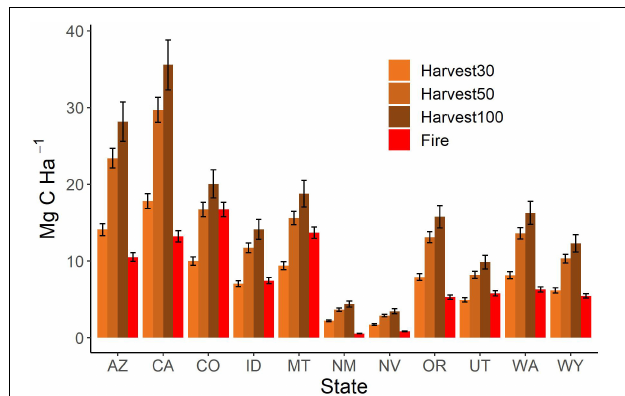
FIGURE 4 | Comparison of per area (Mg C ha − 1 ) hypothetical harvest scenario carbon losses to actual fire emissions. Harvest scenarios were calculated for the exact burn area in these states for 2009–2018. Harvest scenarios are based on 30, 50, and 100% aboveground tree removal rates. Here, a 30% is showing a thin-from-below, 50% harvest is akin to a commercial thin, while 100% would be representative of a clear-cut removal. Fire emissions are based on the fire perimeters of forest fires used in this study. Error bars represent standard error.